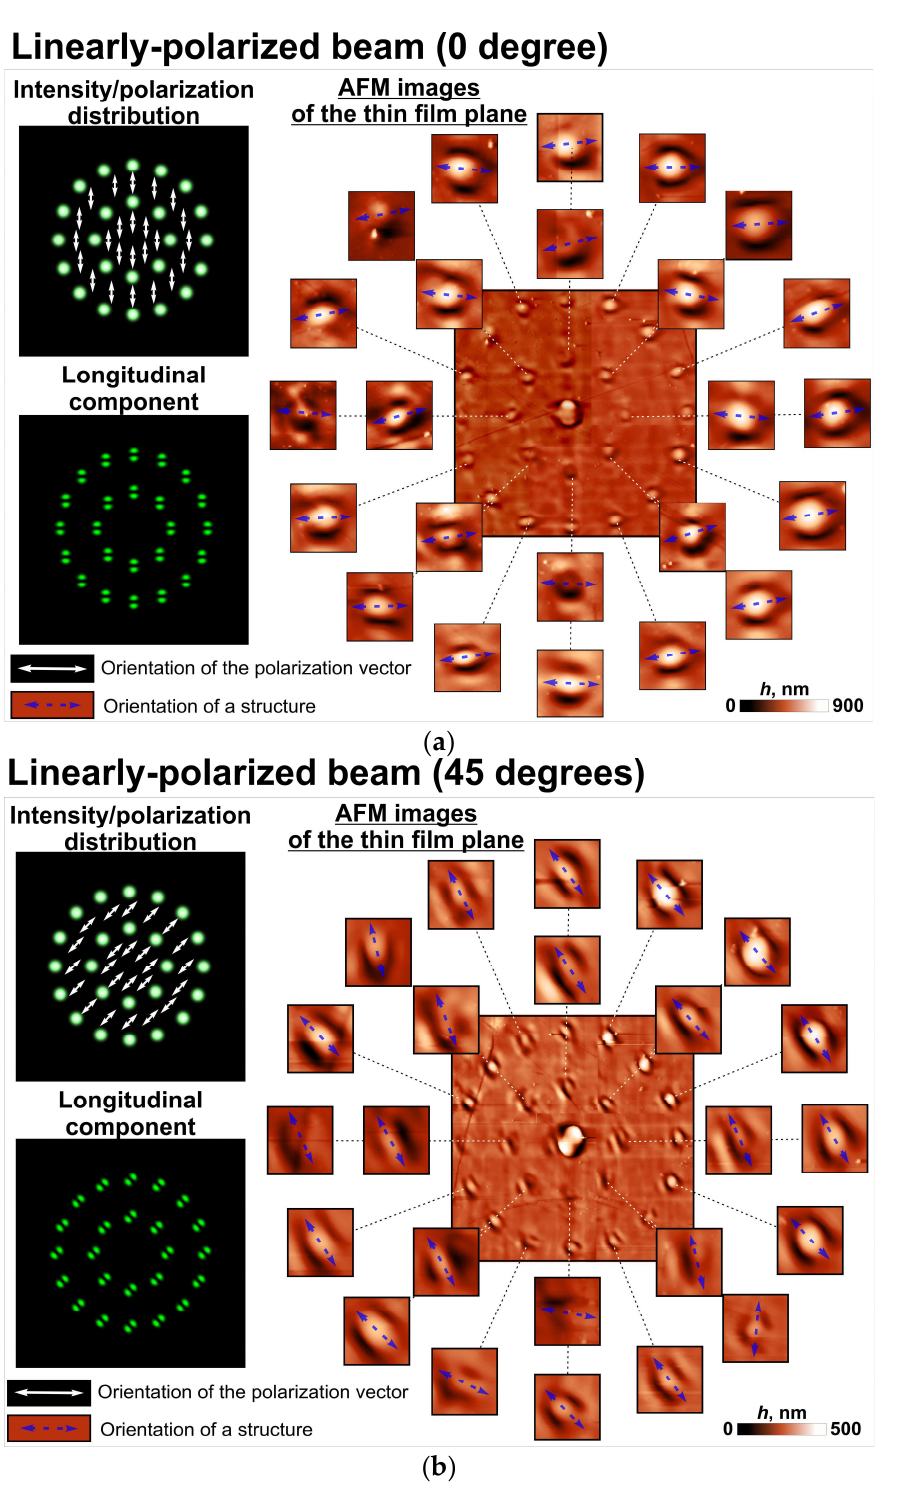
Figure 3. Laser patterning of a thin azopolymer film with a set of modulated linearly polarized spots. Modeling intensity distributions of the used illuminating laser beams as well as atomic force microscopy (AFM) images of the fabricated microstructures for uniform linear polarization with angles of 0 ( a ) and 45 ( b ) degrees are shown.